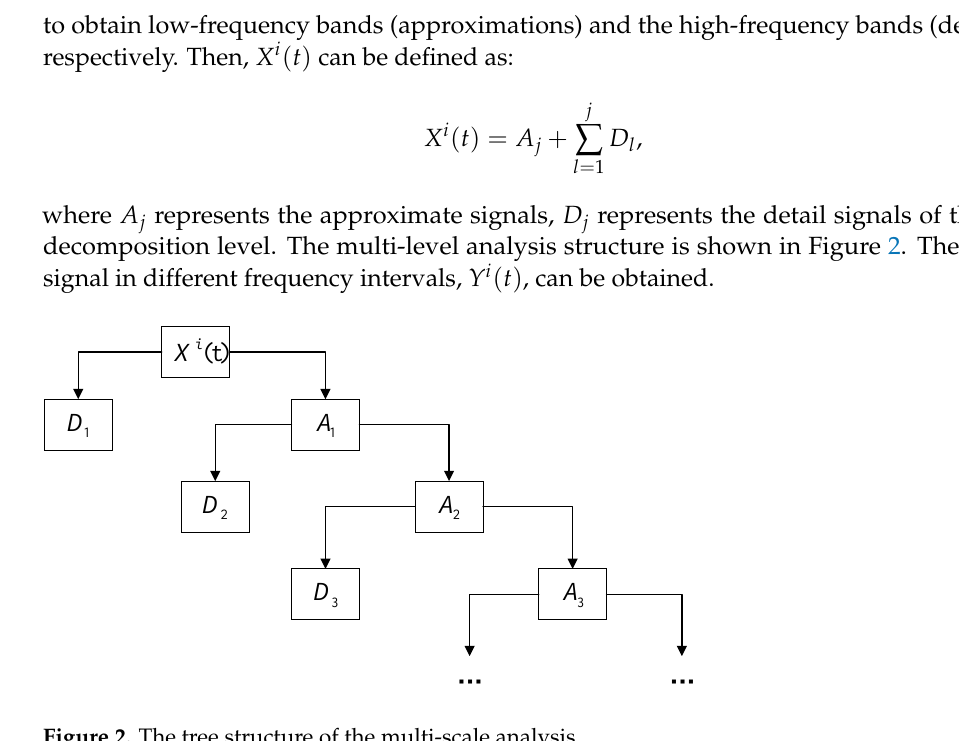
Figure 2. The tree structure of the multi-scale analysis.